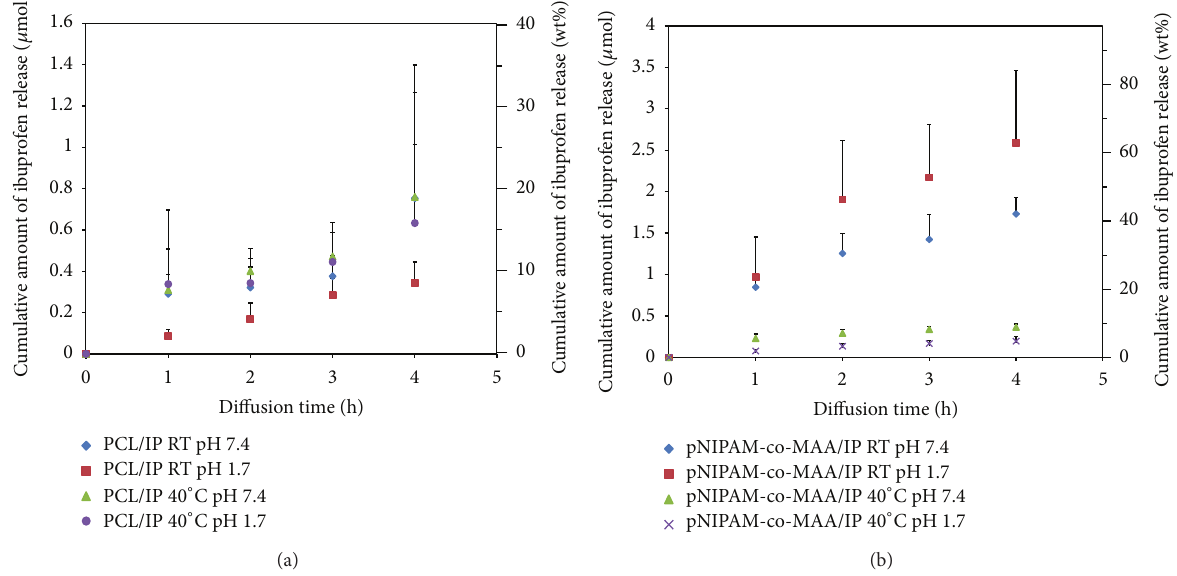
Figure 4: Ibuprofen release profiles from (a) PCL MFs containing 50 mg Ibuprofen/g MFs, (b) pNIPAM-co-MAA MFs containing 50 mg Ibuprofen/g MFs. ∗ std. bars were obtained from the measurements of triple diffusion studies. RT: room temperature 22 ∘